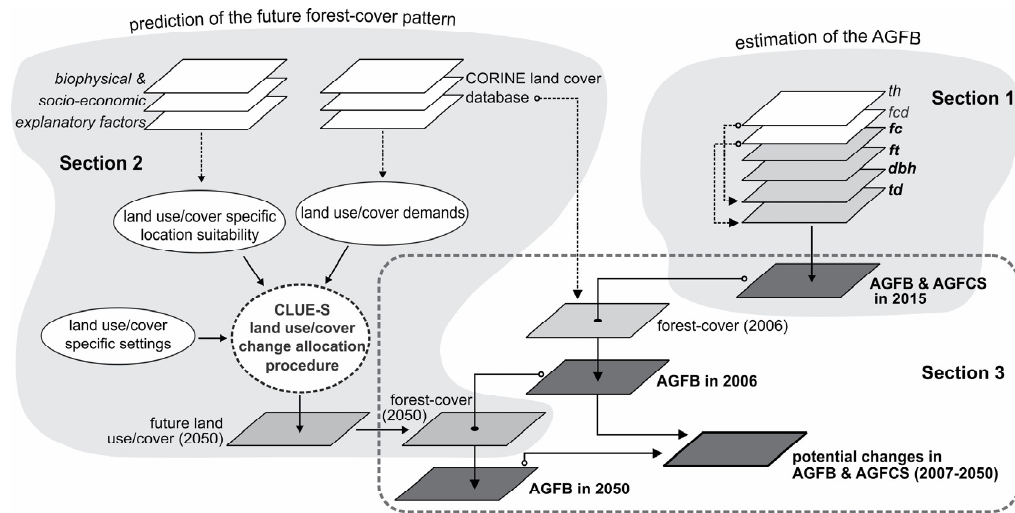
Figure 2. The flowchart of the modeling procedure used to estimate the future potential variation in aboveground forest biomass (AGFB) and aboveground forest carbon stock (AGFCS) quantity according to the estimated AGFB in 2015 and the simulated forest-cover pattern change in 2050.